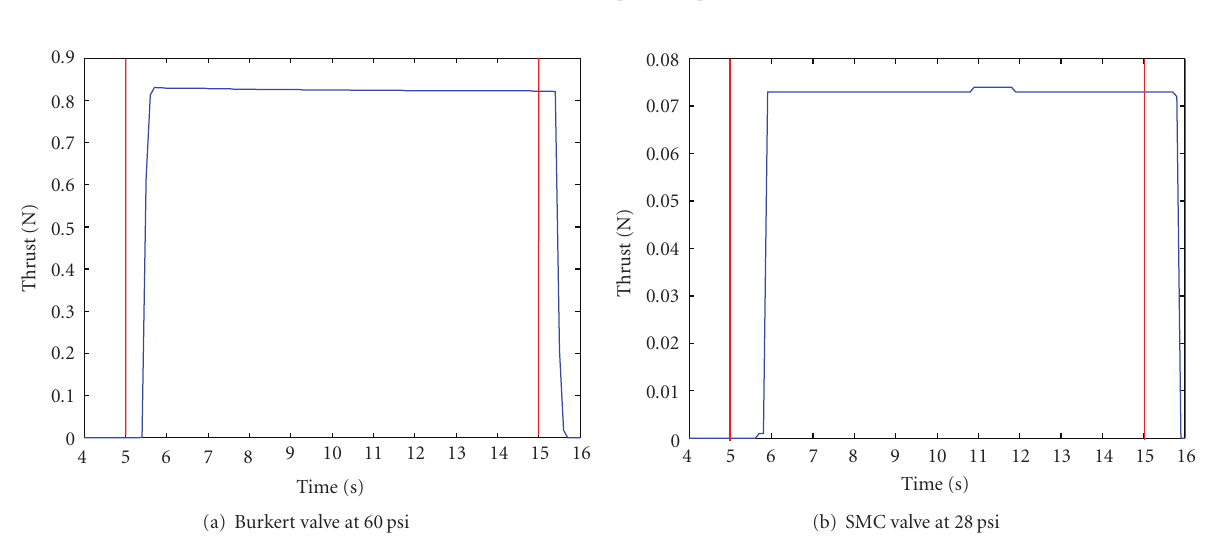
Figure 10: Thruster characterization